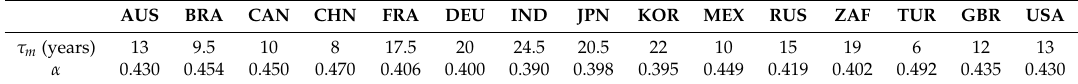
Table 1. List of τ m versus α for the set of 15